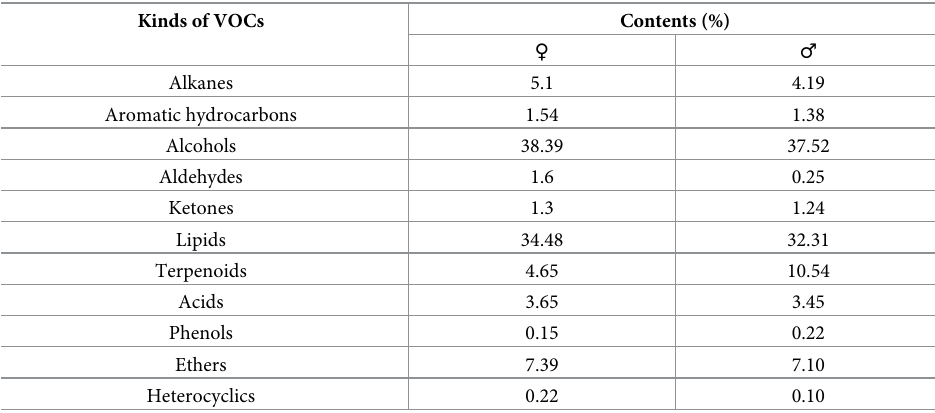
Table 1. Classification of VOCs in the adults of P . xuthus